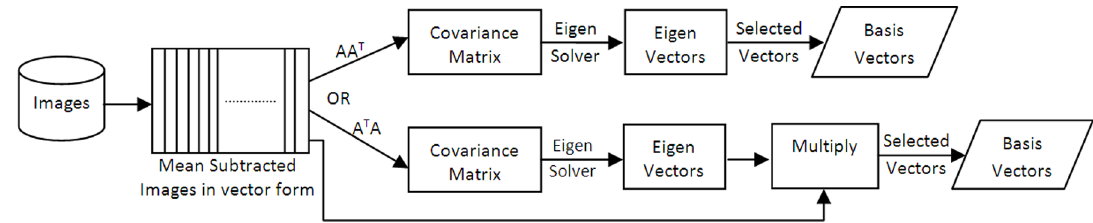
Figure 2. PCA Training Process. doi:10.1371/journal.pone.0056510.g002 PLOS ONE |